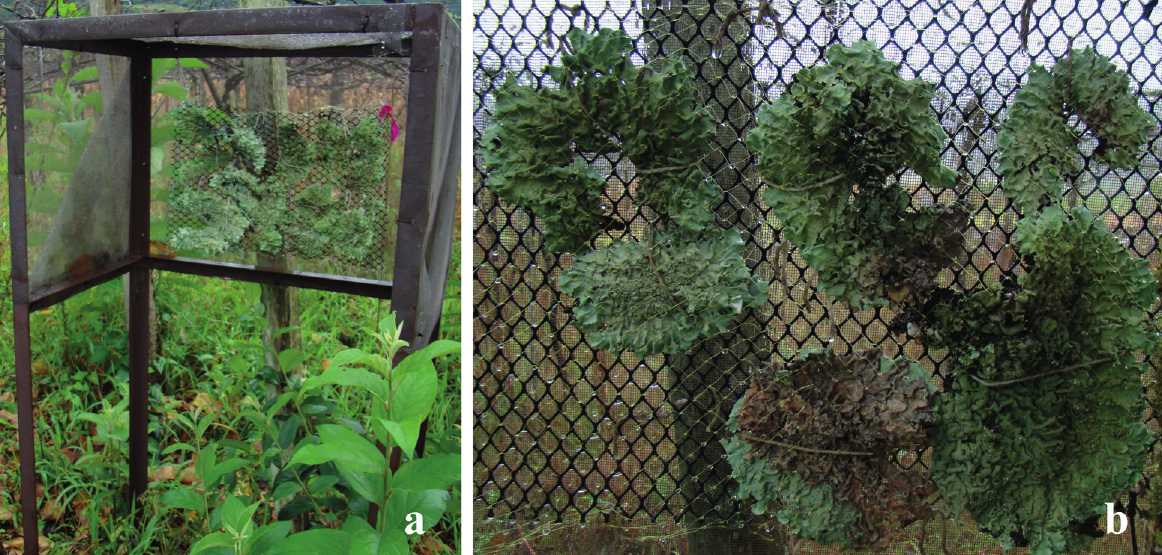
Figure 2 - a. Thalli of Parmotrema tinctorum exposed in the standardized structures. b. Detail of P. tinctorum in the synthetic nettings after three months of